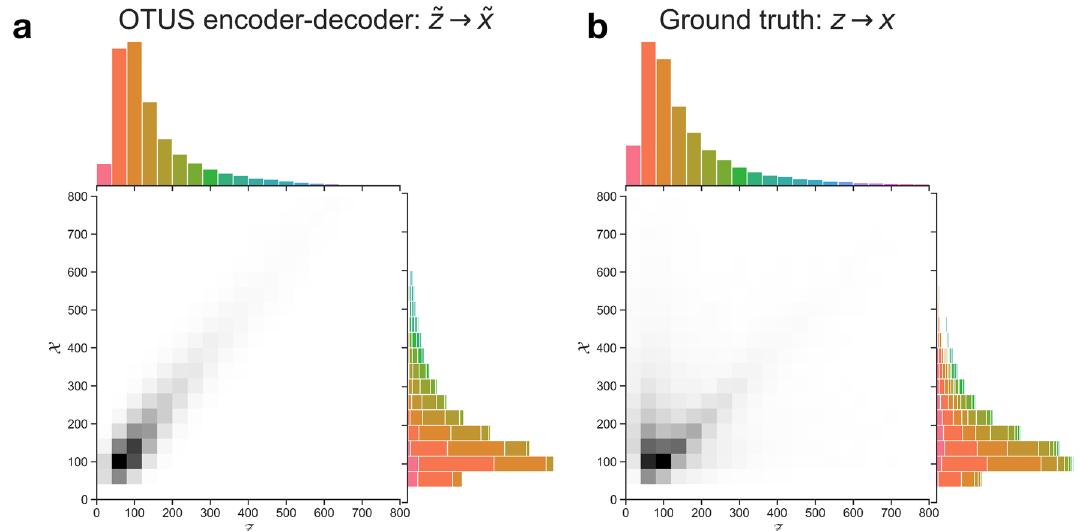
Figure 7. Visualization of the transformation from Z → X in the t ¯ t study for the energy of the b quark in Z to energy of the leading jet in X . ( a ) The learned transformation of the decoder, p D ( x | z ) . ( b ) The true transformation from the simulated sample, for comparison, though the true ( z , x ) pairs are not typically available and were not used in training. Note that the b quark will not always correspond to the leading jet, see the text for details. Colors in the X projection indicate the source bin in Z for a given